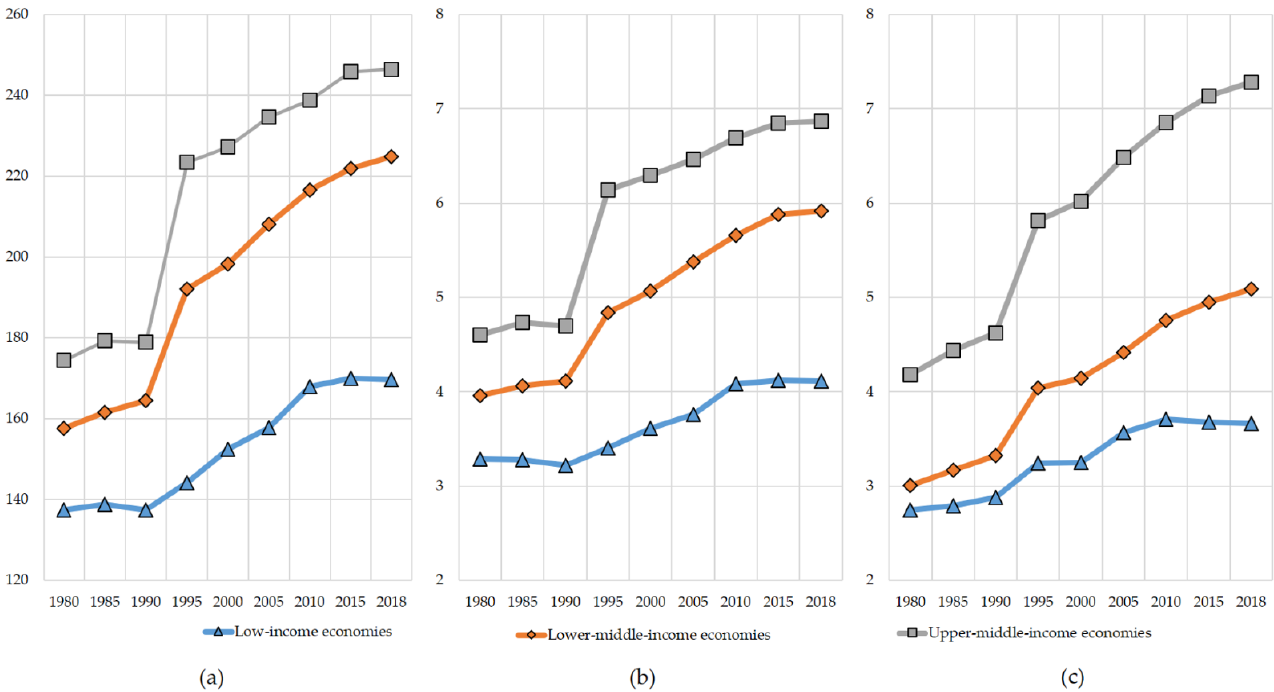
Figure 1. Changes in ( a ) food supply, kcal/capita/day; ( b ) protein supply, g/capita/day; and ( c ) fat supply, g/capita/day in low-income, lower-middle-income, and upper-middle-income economies in 1980 – 2018. Source: authors’ development. Cereal availability is highest in low-income countries among the three groups of economies included in the study (about 390 g/capita/day compared to 260 g/capita/day in upper-middle-income countries). This value has not changed much over decades, and the